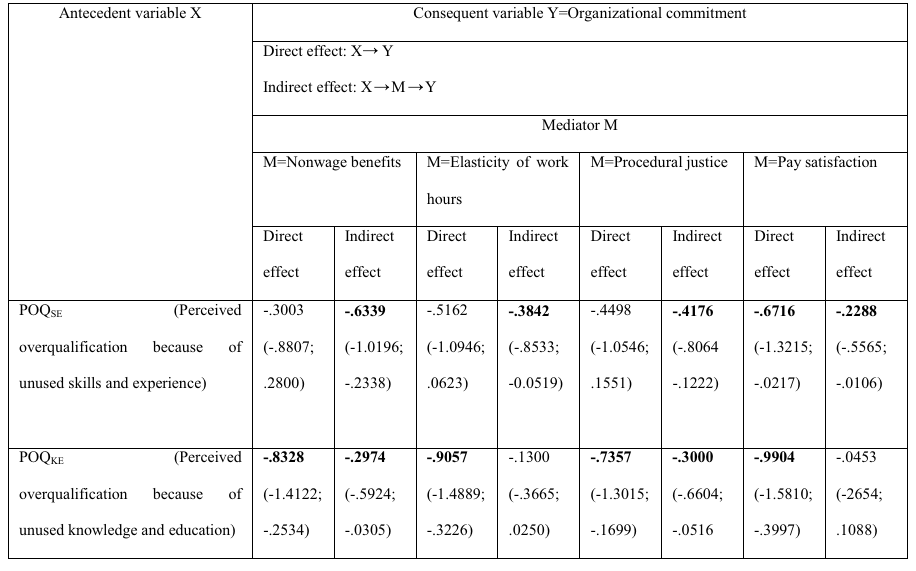
Table 6 Direct effects of Overqualification ( POQ following mediators: Nonwage benefits; Elasticity of work hours; Procedural justice; Pay